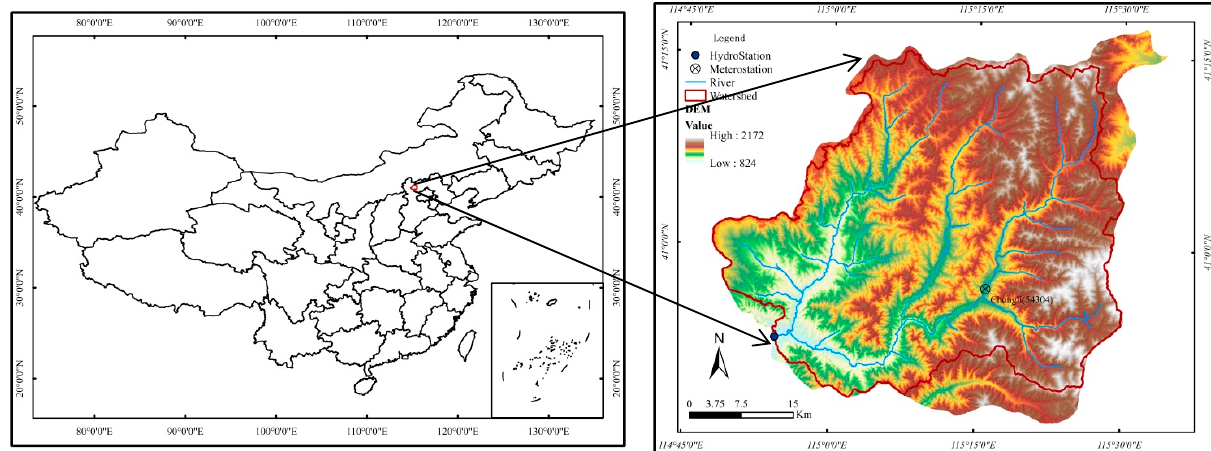
Figure 1. Location of the Qingshui River in Chongli County, hydrological station and climate station.